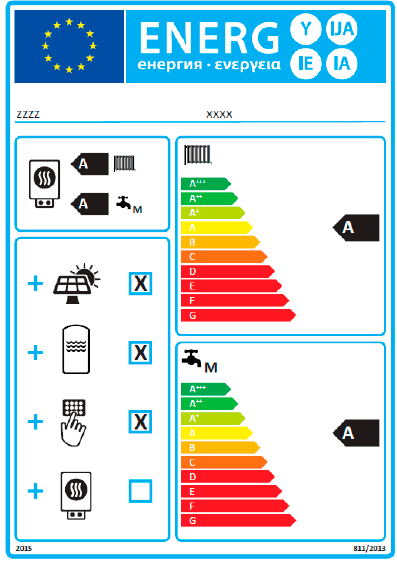
Figure 6. Label for the package of combination heater, temperature control and solar device in the case study.